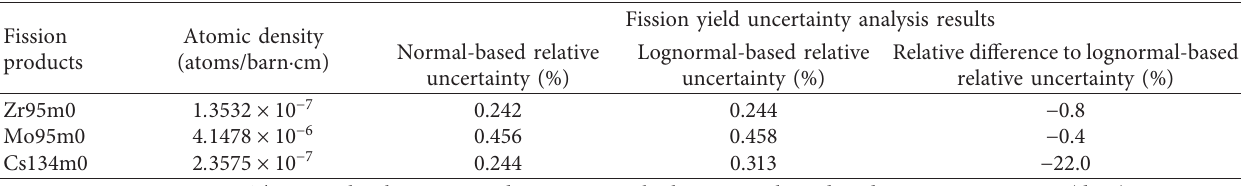
Figure 21: Relative uncertainties of Cs134m0 against fuels average burnup values. Lognormal-based sampling results (blue line) and normal-based sampling results (orange line) are plotted. The shades in this figure are the 95% confidence interval of relative uncertainties. Table 7: Uncertainty analysis results of Zr95m0, Mo95m0, and